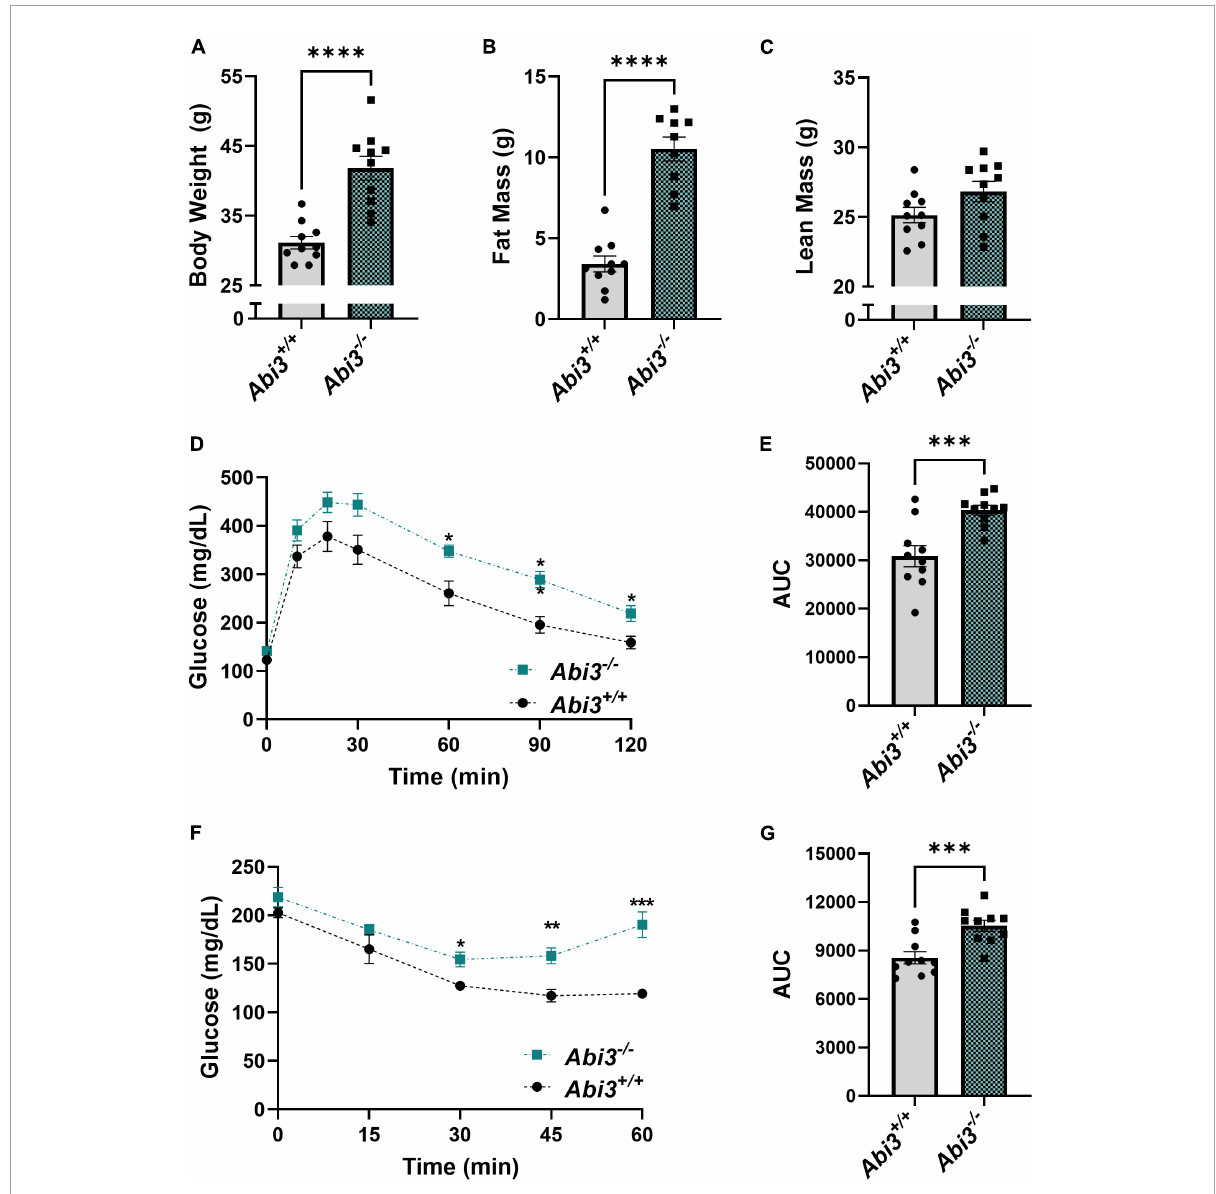
FIGURE1 Abi3 − / − mice exhibit increased body weight and fat mass and impaired glucose tolerance and insulin sensitivity. (A) Body weight was measured in 15-month-old male Abi3 + / + ( n = 10) and Abi3 − / − mice ( n = 10). (B,C) Body composition was measured in these mice using EchoMRI. (D–G) Glucose (GTT) and Insulin tolerance tests (ITT) were performed, and the glucose levels of 15-month-old male Abi3 + / + ( n = 10) and Abi3 − / − mice ( n = 10) were recorded over time. (D) In the GTT, mice were injected with 1 g/kg glucose following a 16 h fast. Blood glucose (mg/dL) was measured via glucometer at 30, 60, 90, and 120 min post injection. (E) The area under the curve for the GTT was calculated. (F) In the ITT, mice were injected with 0.75 units/kg insulin following a 2 h fast. Blood glucose (mg/dL) was measured via glucometer at 15, 30, 45, and 60 min post injection. (G) The area under the curve for ITT was calculated. Data represent mean ± SEM. For GTT and ITT time-course, 2-way ANOVA with Tukey’s post-hoc test was used. For all other comparisons, unpaired t -test was used; ∗ p < 0.05, ∗∗ p < 0.01, ∗∗∗ p < 0.001, and ∗∗∗∗ p < 0.0001.